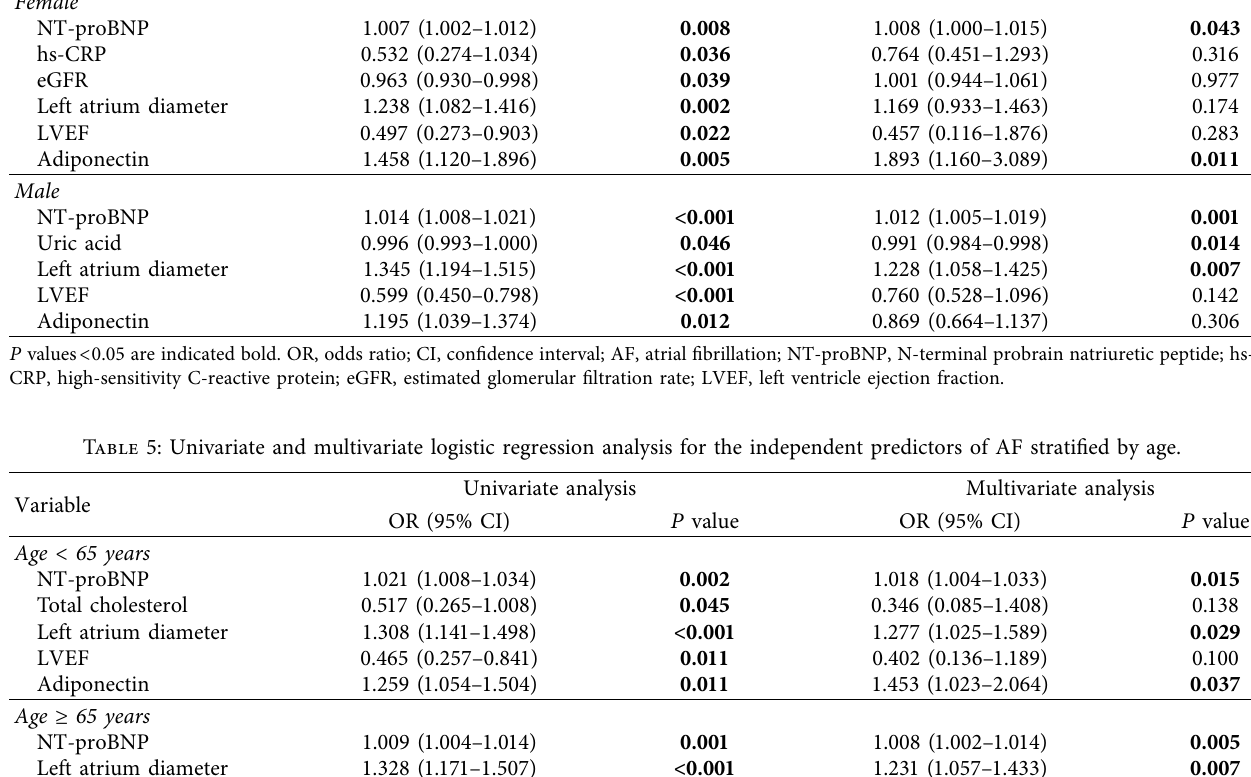
Table 4: Univariate and multivariate logistic regression analysis for the independent predictors of AF stratified by gender. Variable